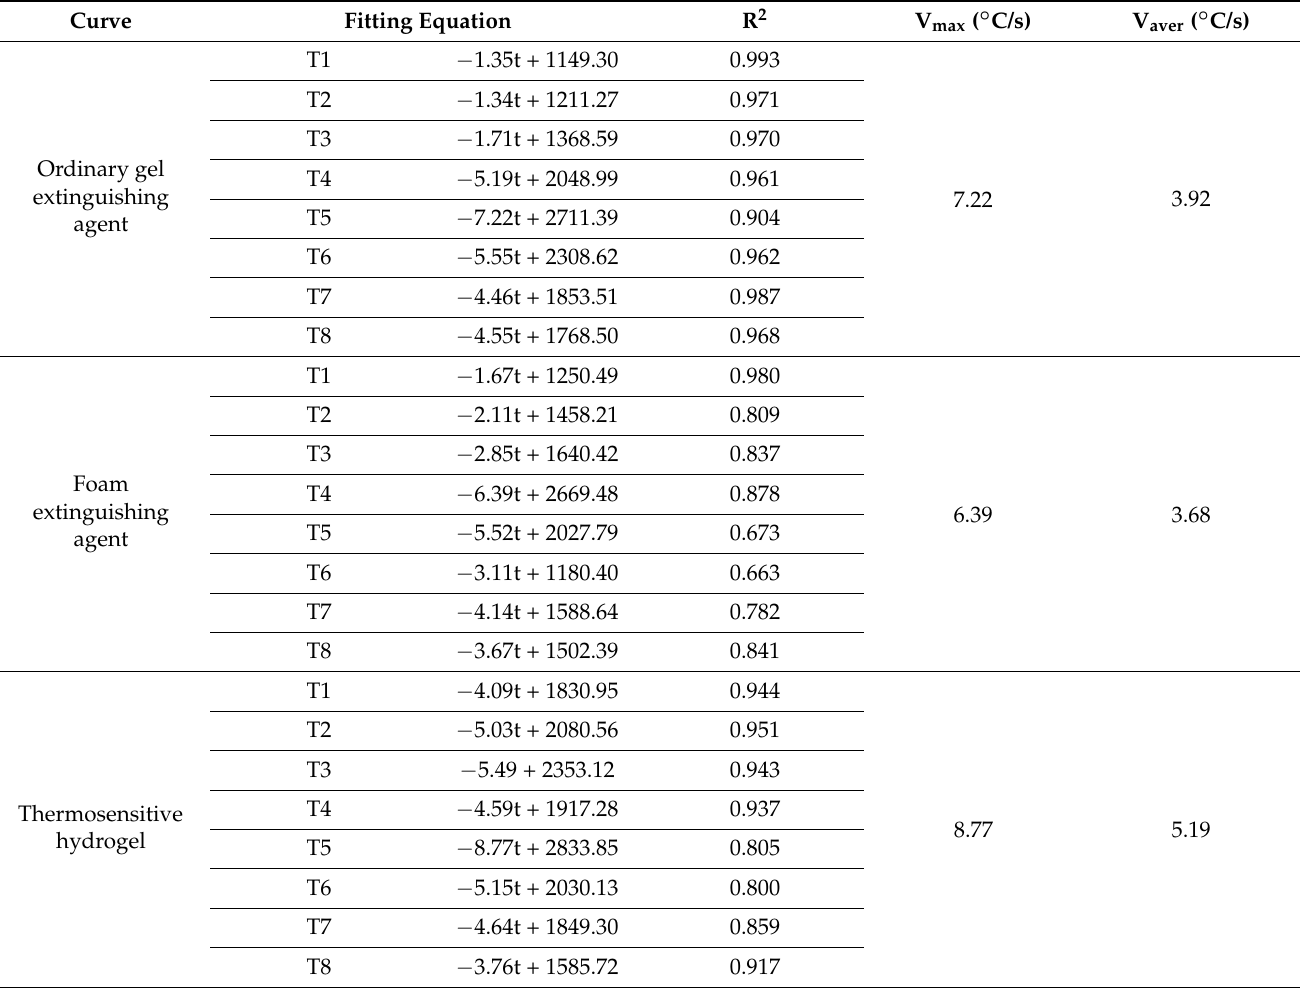
Table 3. The cooling efficiency linear fitting results of extinguishing agents.